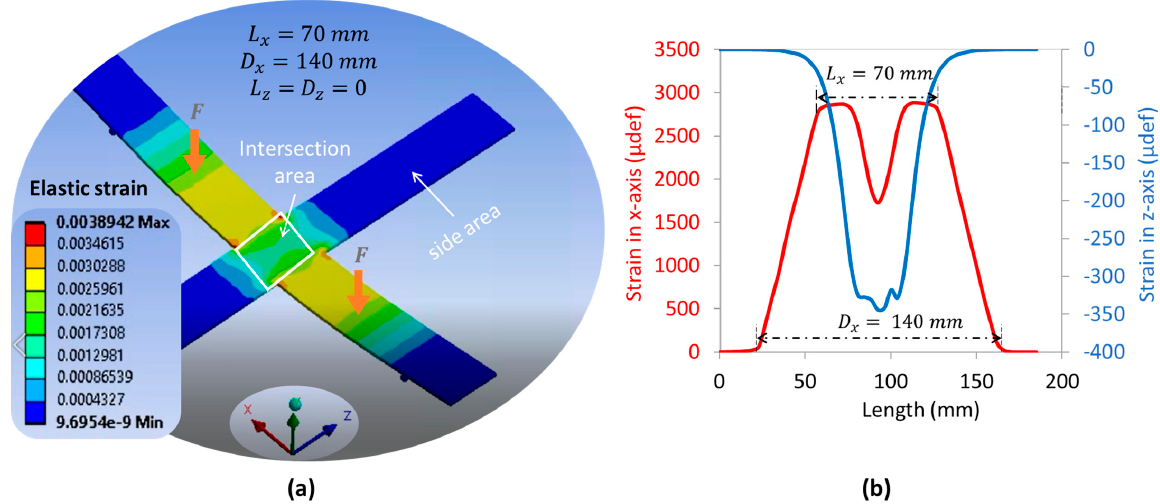
Figure 6. Unidirectional model using FEM: ( a ) four-point flexure design with load applied on x -axis only; ( b ) strain in both x- and z -axis versus their own length.